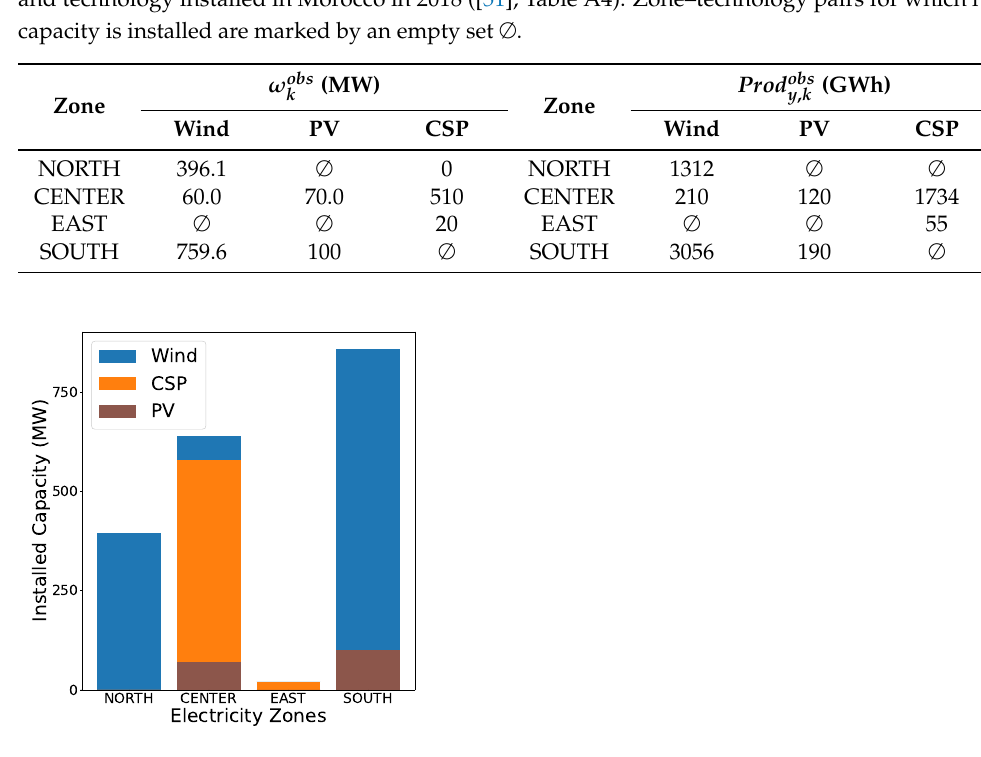
, (Right) per zone y , k